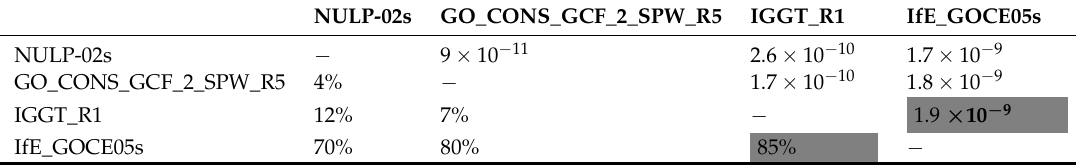
Table A3. Strictly upper triangular matrix: absolute values ∆ C 2,0 = between the estimated normalized Stokes coefficients C 2,0 of degree (cid:96) = 2 and order m = 0 for the recent GOCE-based global gravity field solutions (tide system: tide-free) i , j = NULP-02s [64], GO_CONS_GCF_2_SPW_R5 [65], IGGT_R1 [47], IfE_GOCE05s [48] retrieved from the section Static Models of the WEB page of the International Center for Global Earth Models (ICGEM) at http://icgem. gfz-potsdam.de/tom_longtime. Strictly lower triangular matrix: maximum values of the percent error ψ computed from Equation (6) by assuming the figures in the strictly upper triangular matrix for the uncertainty in C 2,0 . The semimajor axis a and the inclination I of CL were allowed to vary within a range of a CL = 12,270 ± 20 km, I CL = 70.16 ± 0.5 deg, respectively. Cfr. with Figure A2.